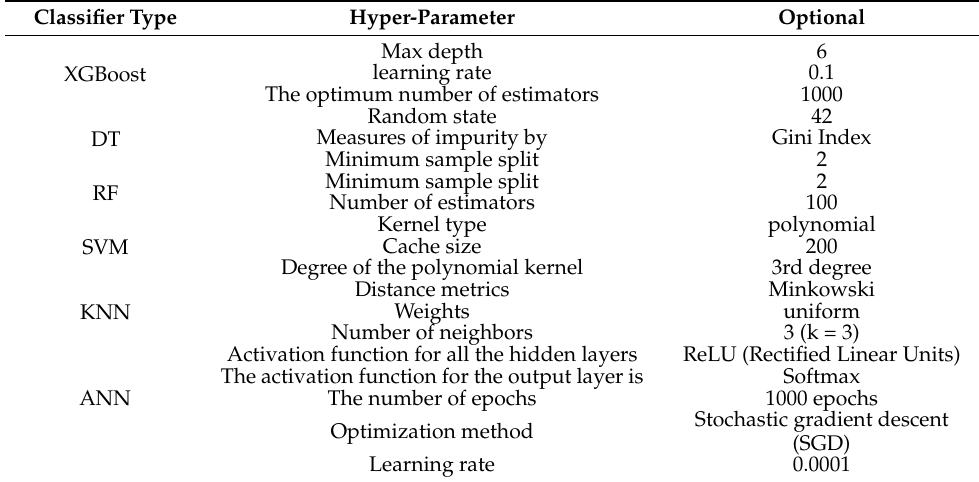
Table 1. The hyper-parameter settings for different classifier